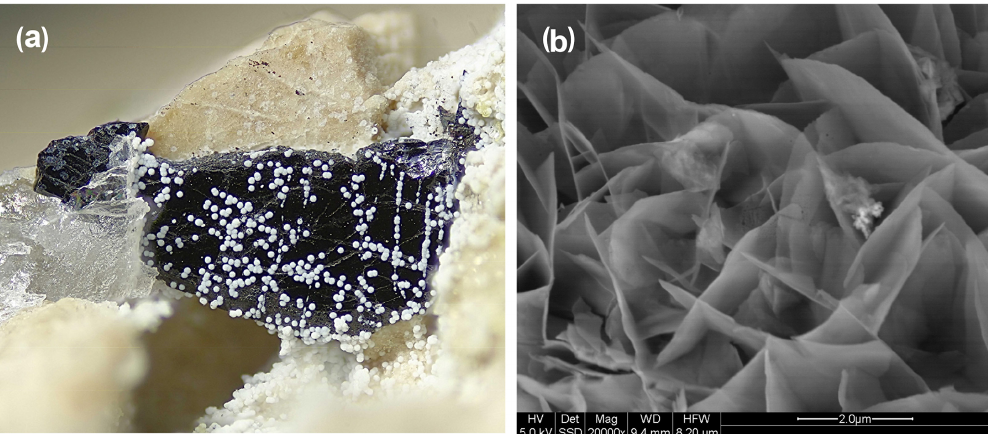
Figure 3. (a) White spheroids of iangreyite on black columbite and yellow altered zwieselite (FOV = 2.4mm). Photo by Volker Betz. (b) SEM BSE image of microtexture of an iangreyite spheroid.